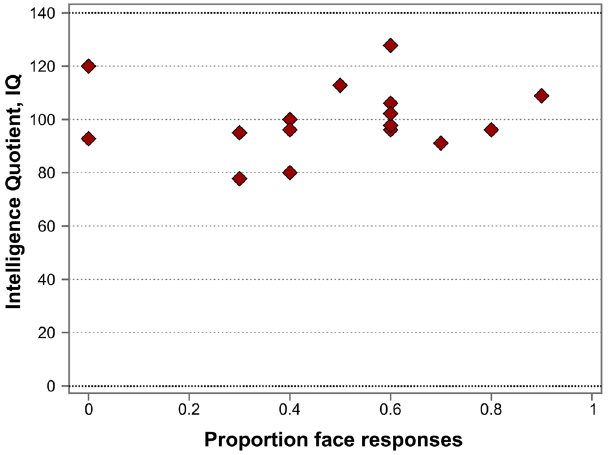
Figure 6. Face resemblance and the general IQ scores in ASD individuals. No substantial link occurs between face resemblance (as proportion of face responses) and the IQ